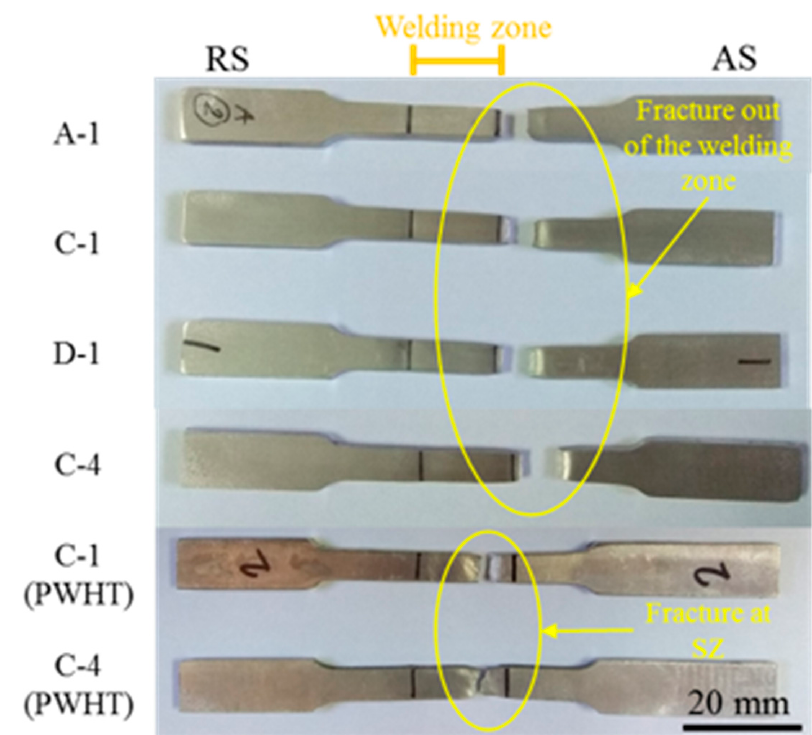
Figure 11. Failure position of similar joints of Al6061(T6) after the tensile test.